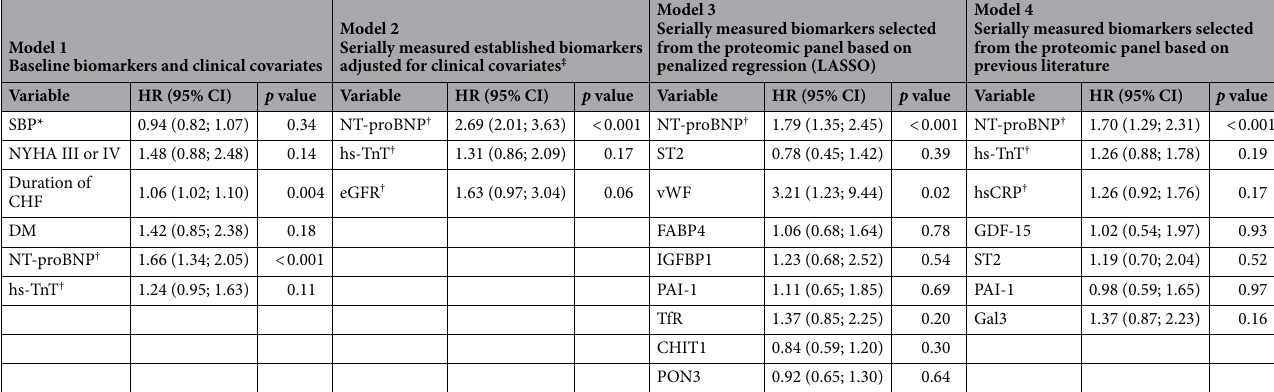
Table 2. Multivariable models predicting clinical outcome in the study population (N = 250 patients). HRs and 95% CIs are given per 1 SD increase in biomarker expressed in log 2 of normalized protein expression units. CHF Chronic heart failure, CHIT1 Chitotriosidase-1, CRP C-reactive protein, DM Diabetes mellitus, eGFR Estimated glomerular filtration rate, FABP4 Fatty acid-binding protein 4, Gal3 Galectin 3, GDF- 15 Growth/differentiation factor 15, IGFBP-1 Insulin-like growth factor-binding protein 1, hs-TnT High sensitivity troponin T, NT-proBNP N-terminal prohormone brain natriuretic peptide, NYHA New York Heart Association, PAI-1 Plasminogen activator inhibitor 1, PON3 Paraoxonase 3, SBP Systolic blood pressure, ST2 protein Suppressor of tumorigenicity 2, TR Transferrin receptor protein 1, vWF von Willebrand factor. *HR and 95% CI is given per 10 mmHg change. † HR and 95% CI is given per doubling. ‡ Covariates include: SBP, NYHA class III or IV, duration of CHF (years), diabetes mellitus, baseline NT-proBNP, baseline hs-TnT.